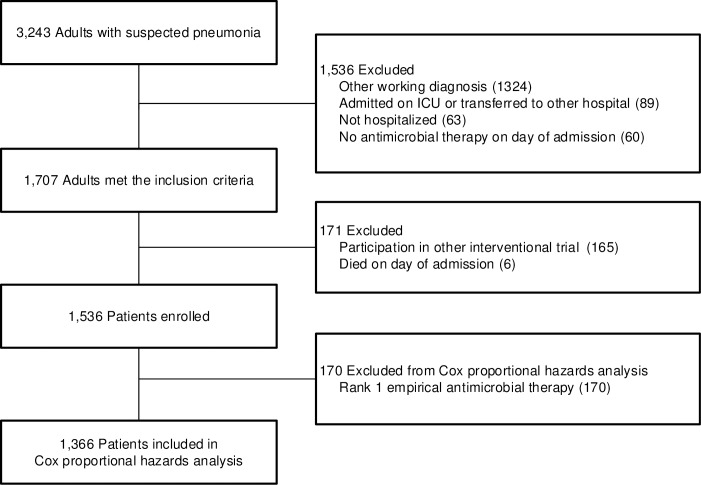
Patient selection.